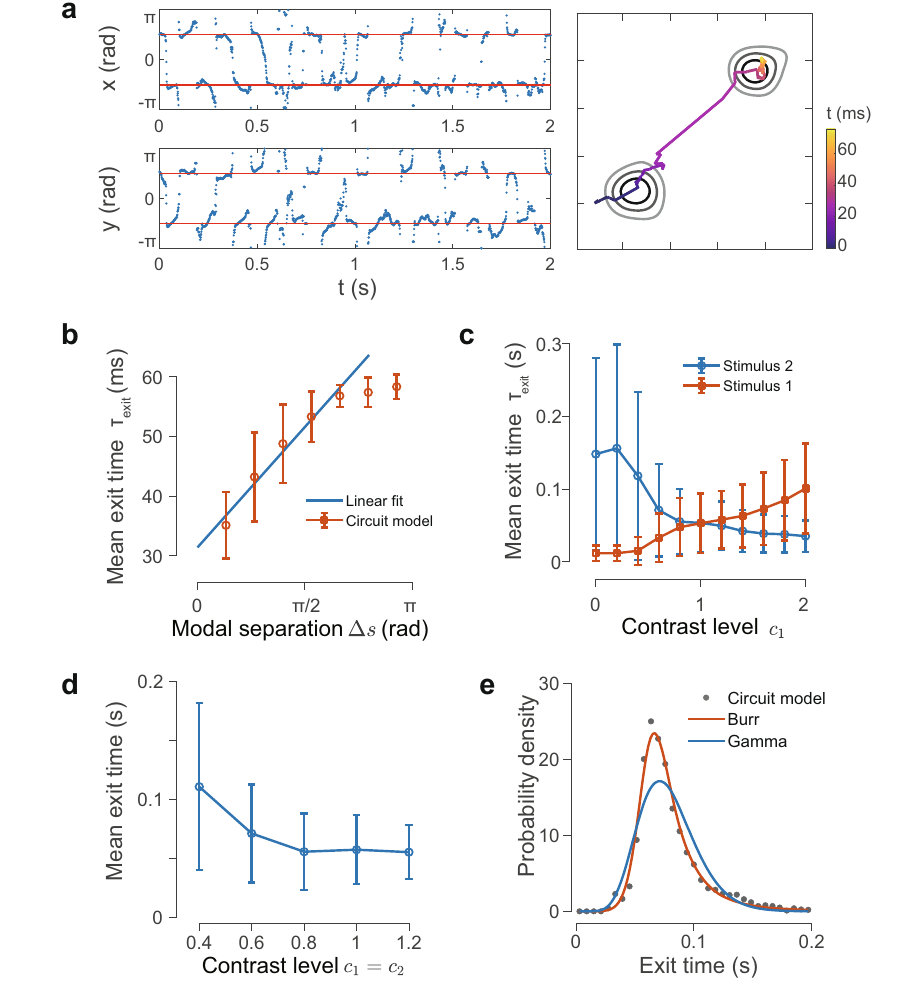
Fig. 8 | Circuit implementation of FNS for sampling bimodal distributions. a Time series of the x - and y -coordinates of the sample path when c 1 = c 2 =1. Sam- ples (blue dots) are concentrated around the stimuli (red solid line) and switch rapidly between them without being trapped. Right panel: contour plot of the log sample probability density with a segment of the sample path overlaid on top. b Meanexittime (circle) grows linearly with the modal separation (with saturation